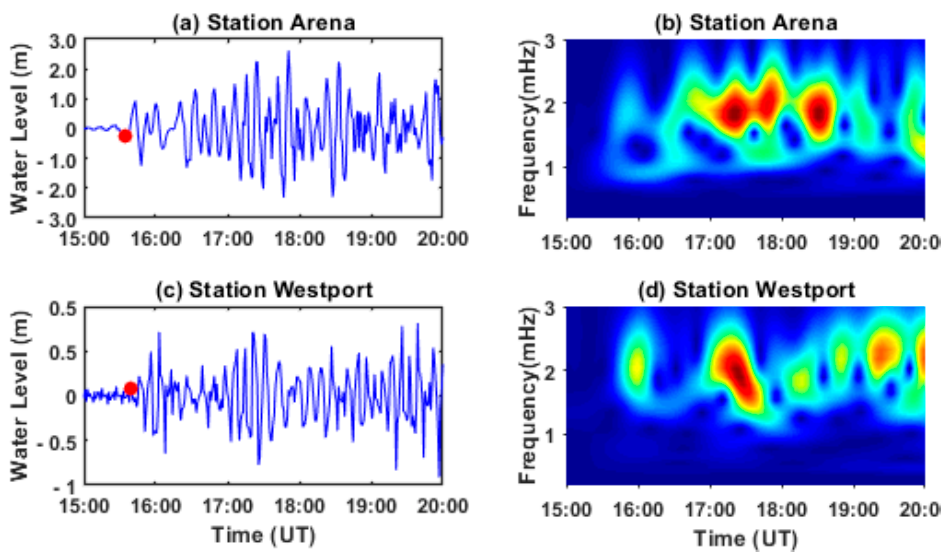
Figure 14. Sea level time series for tide gauges at ( a ) Arena, and ( c ) West Port stations on 11 March 2011. The red points indicate the time of arrival of the tsunami waves at the stations, and the time-frequency analysis for tide gauges at ( b ) Arena, and ( d ) West Port stations. Table 1. The time arrival of tsunami waves to different stations. Station